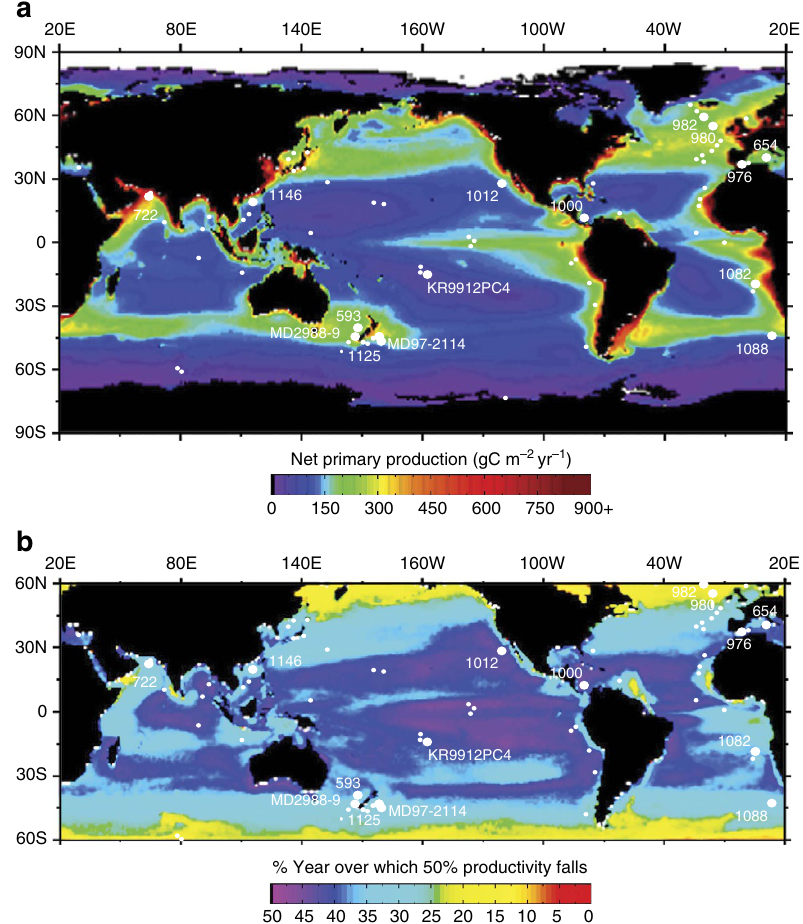
Figure 4 | Distribution of extinction group study sites and modern productivity. Location of core sites on maps showing the mathematical estimates of modern net primary production, and modern unevenness of annual primary production (figure adapted from ref. 53). Sites shown indicate where the Mid Pleistocene benthic foraminiferal extinction group has been studied; the DSDP/ODP site numbers are given for higher-resolution studies 7 that correspond to the sites used to construct Fig. 3. ( a ) Global average net primary productivity 53 . ( b ) The geographic distribution of the seasonal variation of net primary production (seasonality) for the years 1998–2007. The colours refer to the % of the year over which 50% productivity takes place, such that purple indicates no seasonality (colours modified from ref. 53). We propose that glacial MPTseasonality may have been higher than modern seasonality. Note that seasonality is generally lowest in regions where primary productivity is